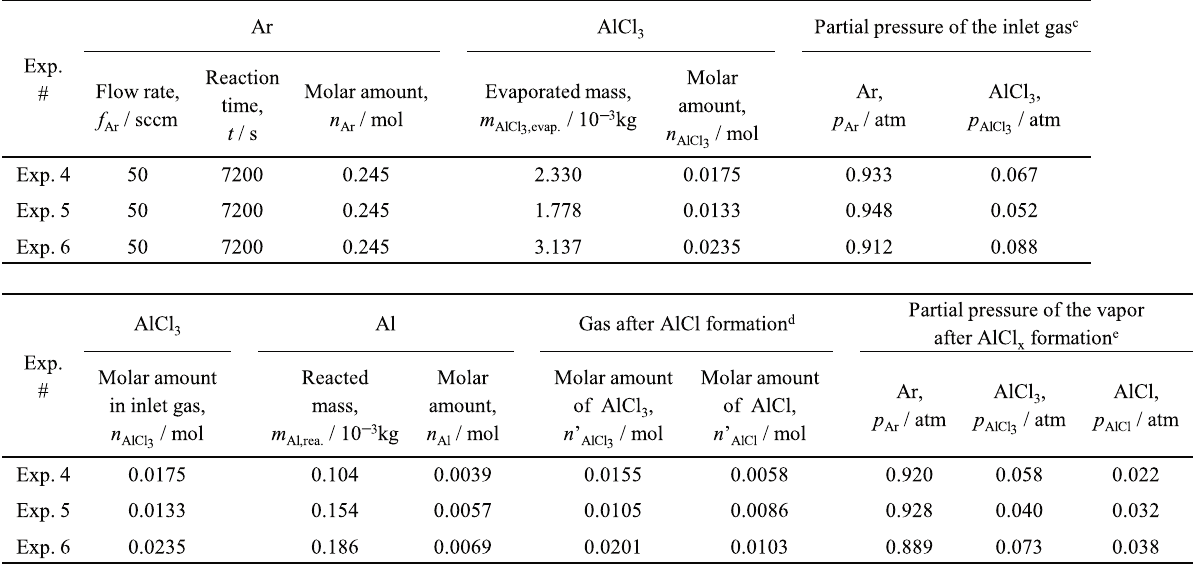
Table 9. Compositions of the inlet gas and the vapor after AlCl x formation.